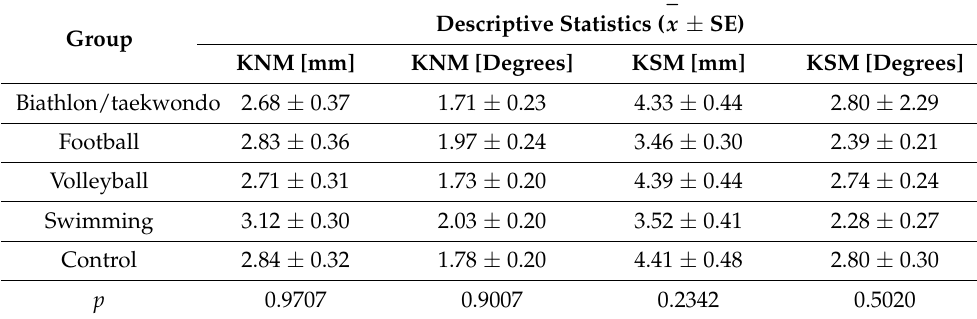
Table 6. Characteristics of the KNM and KSM